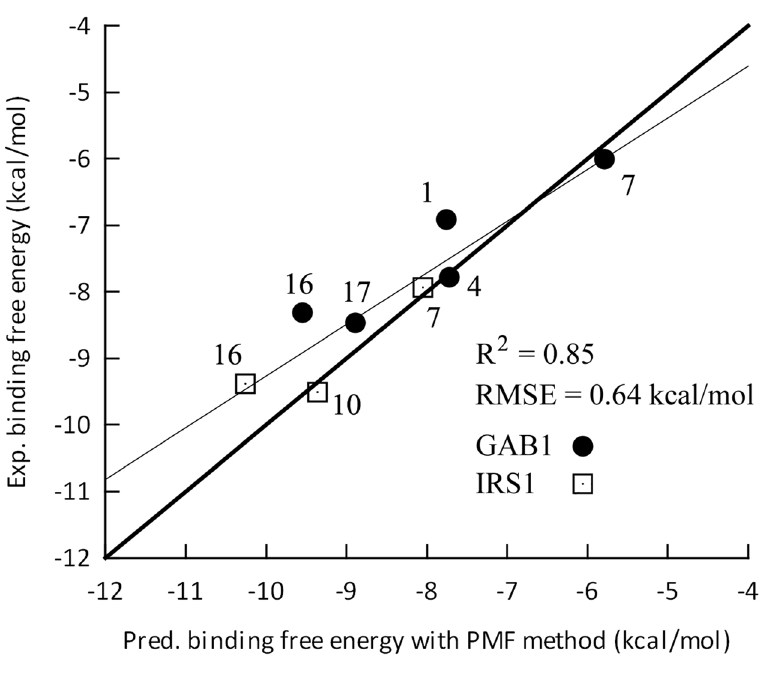
Fig. 6. The correlation between the predicted binding free energies (PMF method) and the experimental ones. The grey line indicates the calculated correlation between predicted and experimental binding free energies, and the black line indicates the ideal correlation. The number beside each point is the corresponding inhibitor ID.